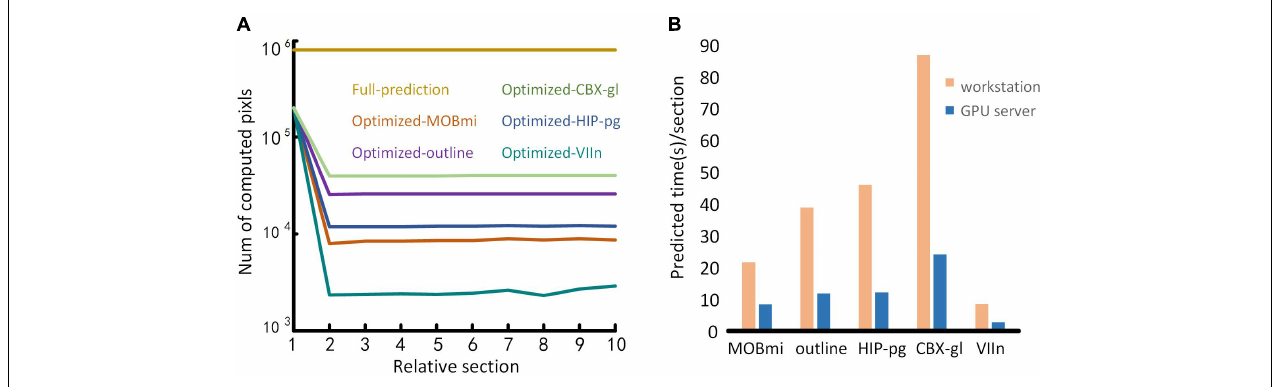
FIGURE 10 | Performance testing. (A) Comparison of the time required for full-image predictions and optimization predictions. The abscissa represents a sequence of ten consecutive coronal images. The ordinate is the number of pixels to be calculated. Different color lines represent the calculation required for different brain regions using full-image predictions and the optimization predictions. (B) Performance of the proposed method on different computing platforms. The abscissa represents the five brain regions, and the ordinate is the average prediction time for each image. The orange and blue bars represent the performances of the workstation and the GPU server platform,